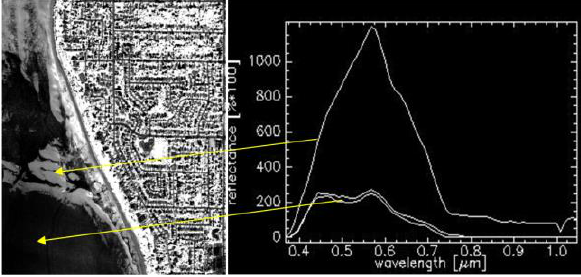
Figure 8.Substrate mapping (left) and spectral reflectance signature